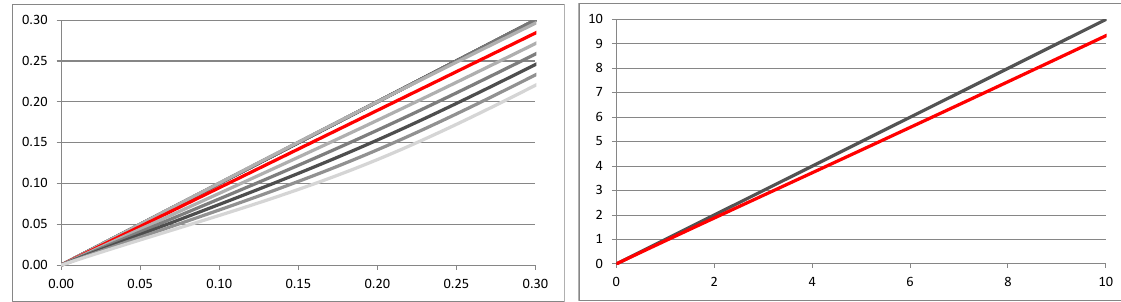
Figure 4. Case of small individual risk aversion parameter α = 0 . 01 < β = 0 . 0301 :